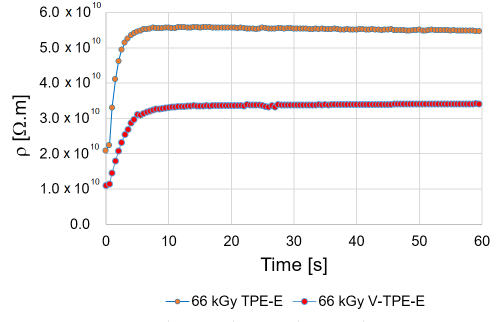
Figure 2. Measurement course of the volume resistivity at voltage of 500 V.